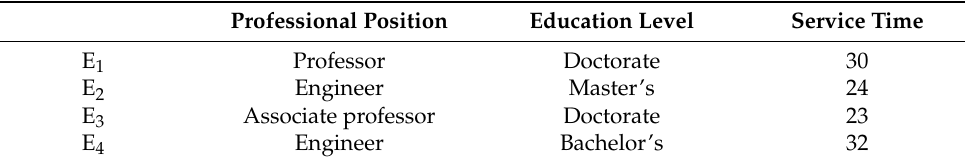
Table 8. Basic information of the experts.